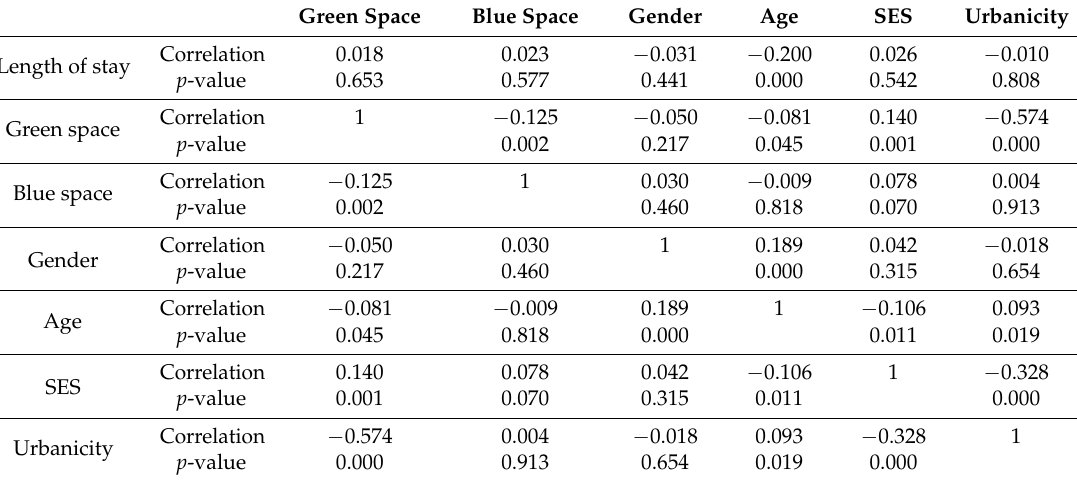
Table 2. Spearman correlation